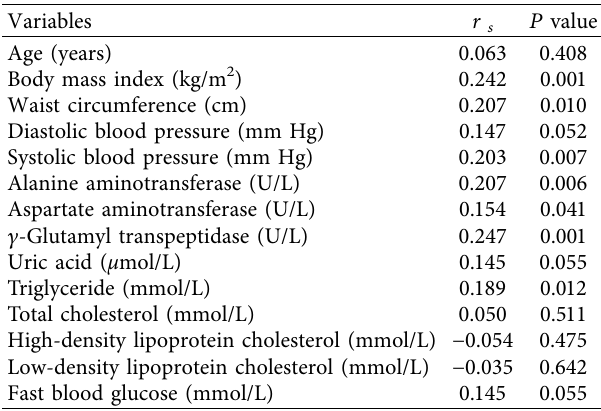
Table 2: Correlation of the serum afamin levels with the an- thropometric and biochemical